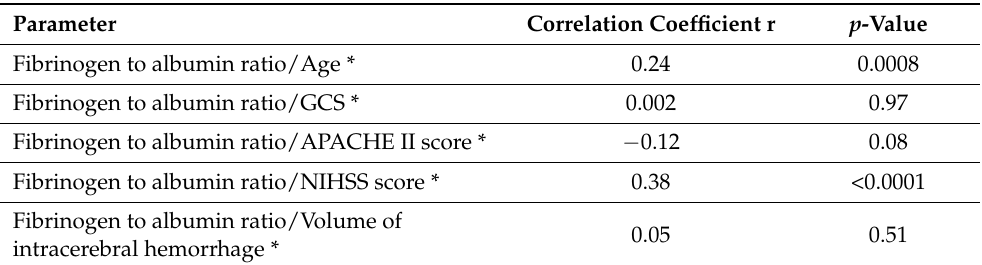
Table 4. Correlation of fibrinogen to albumin ratio with all independent predictors of intrahospital